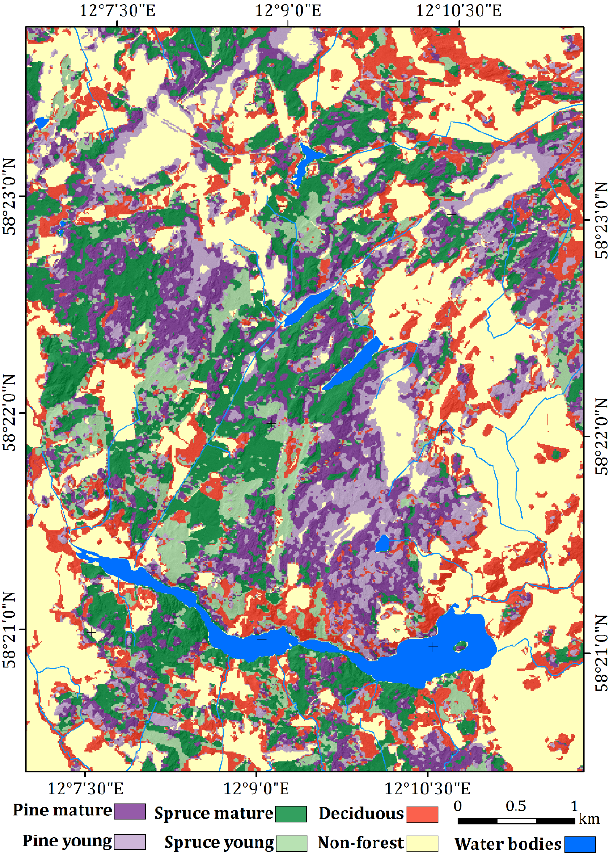
Figure 2. Vegetation map from SPOT-5 data for 29th July 2011 using maximum likelihood classification (10 m pixel resolution); here, deciduous forest consists mostly of birch